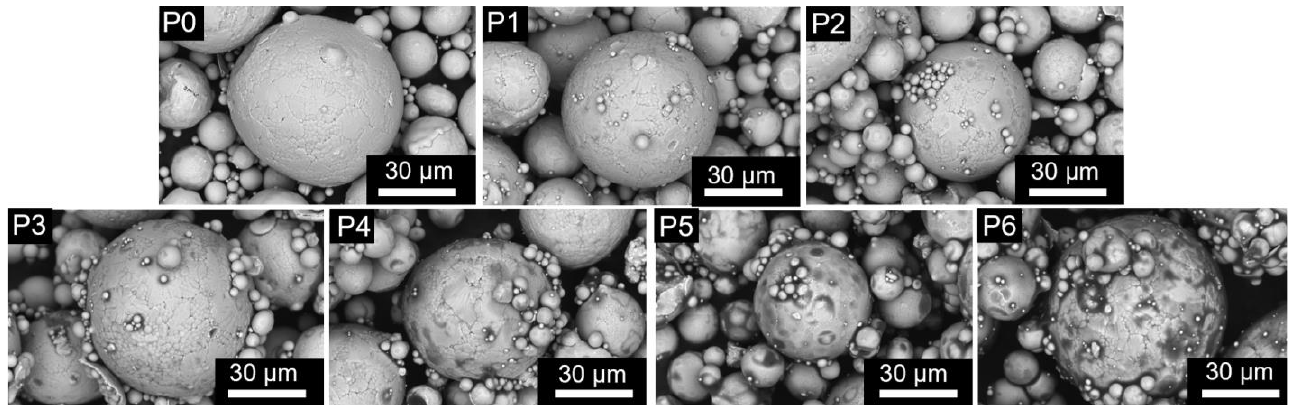
Figure 4. SEM images of FeSiAl powders P0~P6.